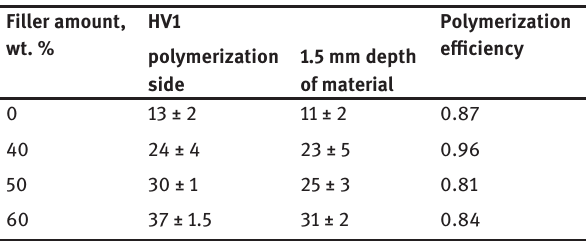
Table 1: The effect of filler amount on microhardness of samples (HV) on the cured side to a depth of 1.5 mm of material and polymerization efficiency; photopolymerisation conditions - 20 second/1 mm material thickness, the power of light curing unit 1400 mW/cm 2 . Filler amount, HV1